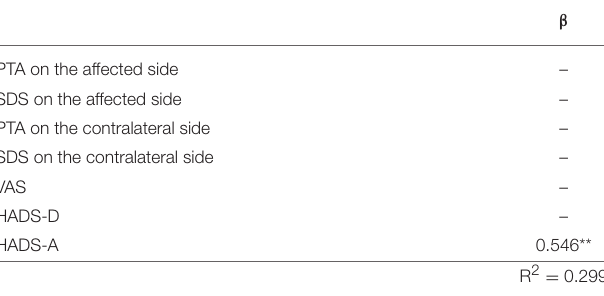
TABLE 4 | Multiple regression analyses of tinnitus severity and the variables hearing impairment, anxiety, and